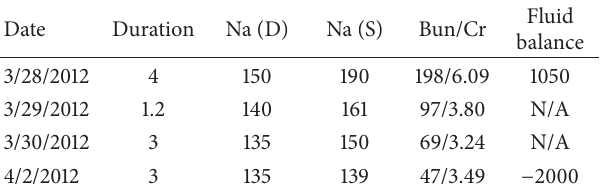
Table 1: Dialysis and fluid